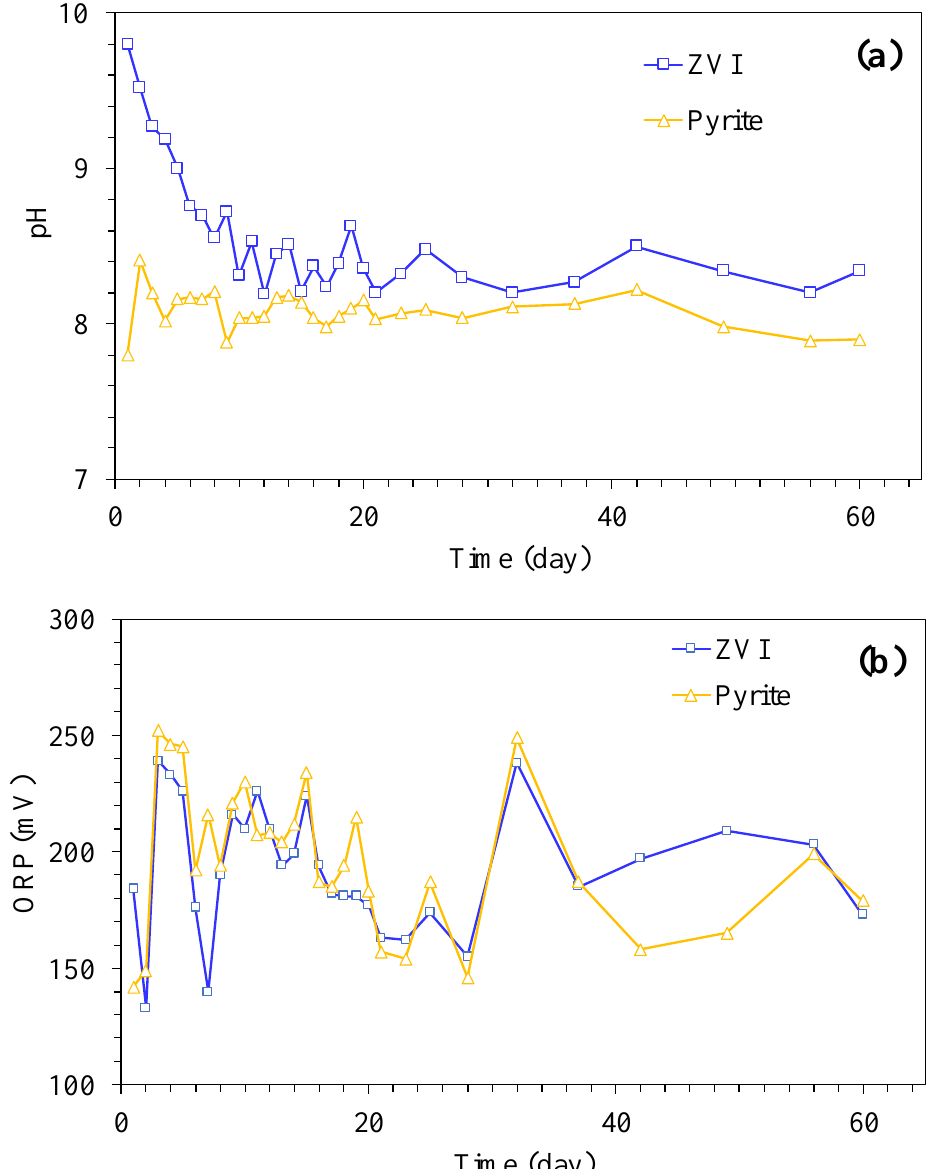
Figure 5. ( a ) pH and ( b ) oxidation-reduction potential (ORP) profiles with ZVI and pyrite activation of S₂O 82− .